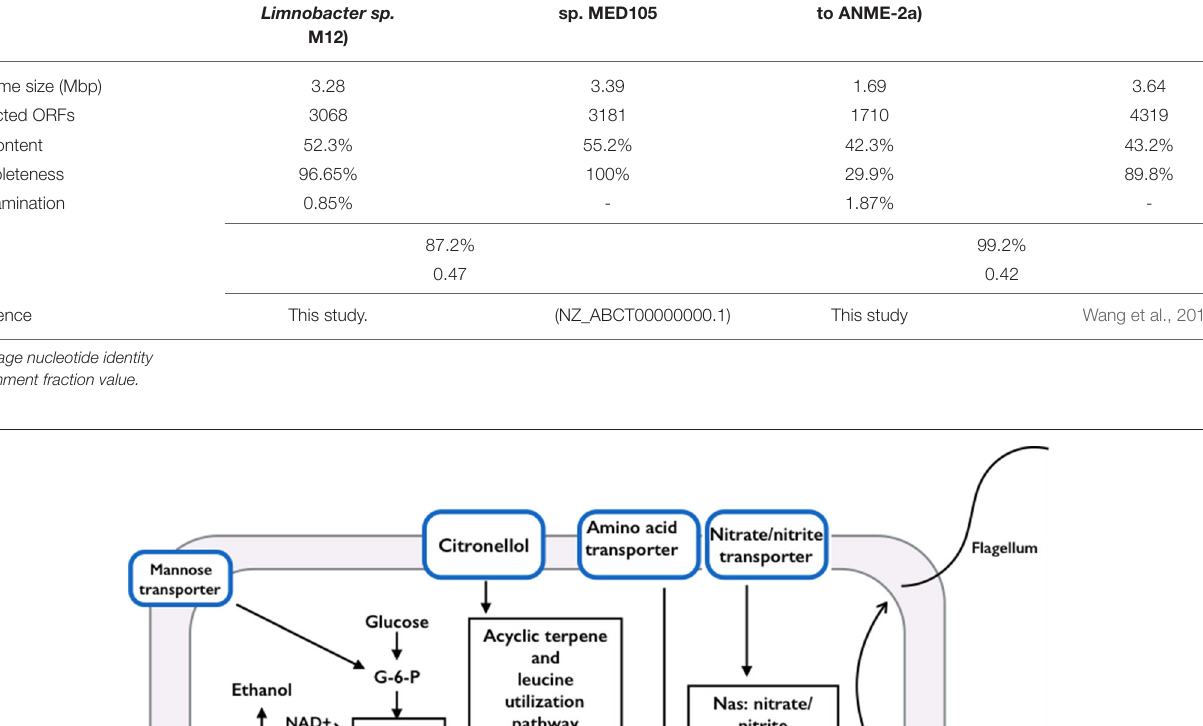
L-amino acids including those with acid, base, amide, and aliphatic side chains. This transporter is composed of four genes ( aapJMPQ ), namely aapJ , which encodes a substrate-binding